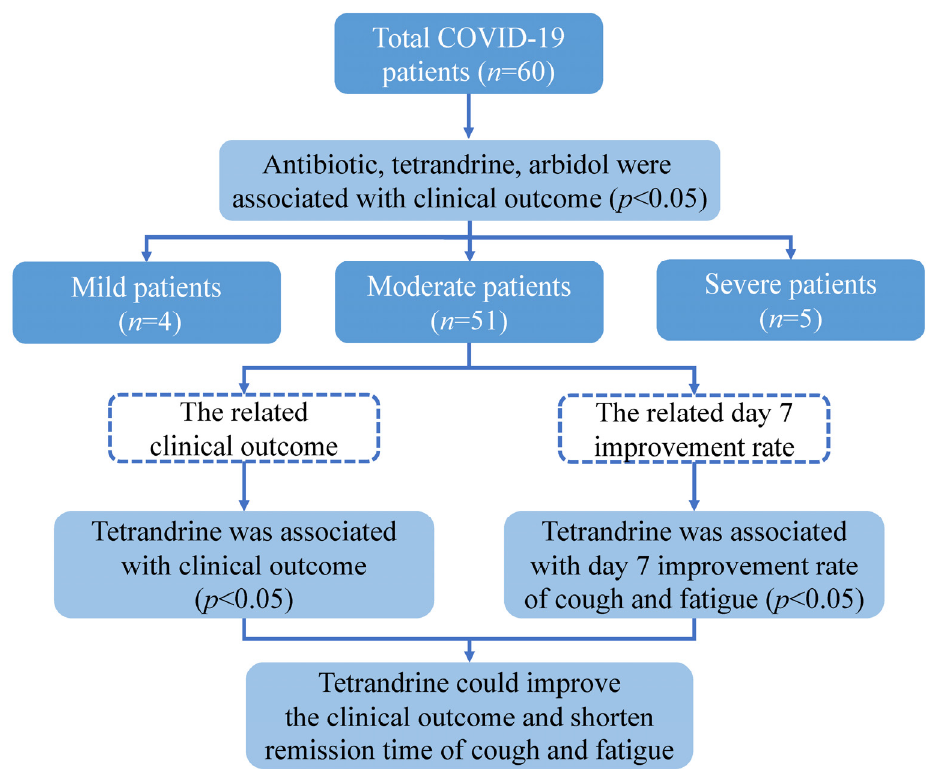
Figure 2. Schematic representation of this study